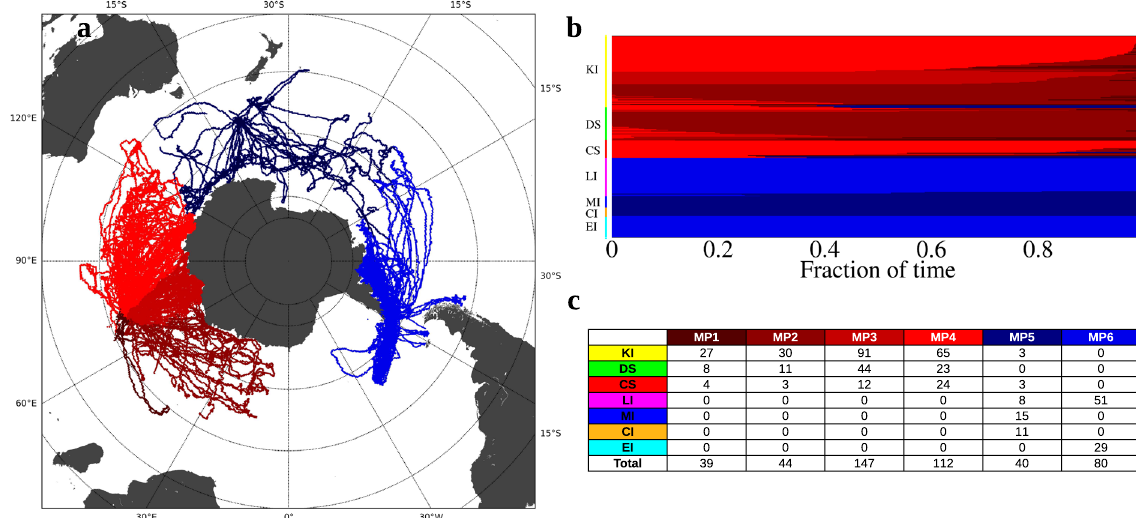
Figure 5. Marine provinces of southern elephant seals in the Southern Ocean. Marine provinces were obtained based on the movement of elephant seals for the transition probability matrix Ω for time window T = 1 day. ( a ) Map of the marine provinces. Red and blue colours indicate the communities at level 0, while the darkness of the colours separates communities at level 1. Map generated with Matplotlib Basemap Toolkit 55 ; ( b ) Fraction of time spent at a given province per individual. Each row corresponds to a single animal, which was tagged at the locations indicated by the colour bar: Kerguelen Island (KI, yellow), Davis Station (DS, green), Casey Station (CS, red), Livingston (LI, magenta), Macquarie (MI, blue), Campbell (CI, orange) and Elephant (EI, cyan) Islands. The rows were divided into the colours of the provinces that each seal uses, and their lengths are proportional to the time spent in them; ( c ) Number of elephant seals visiting each marine province (MP) for every deployment location; marine provinces were ordered according to ( a